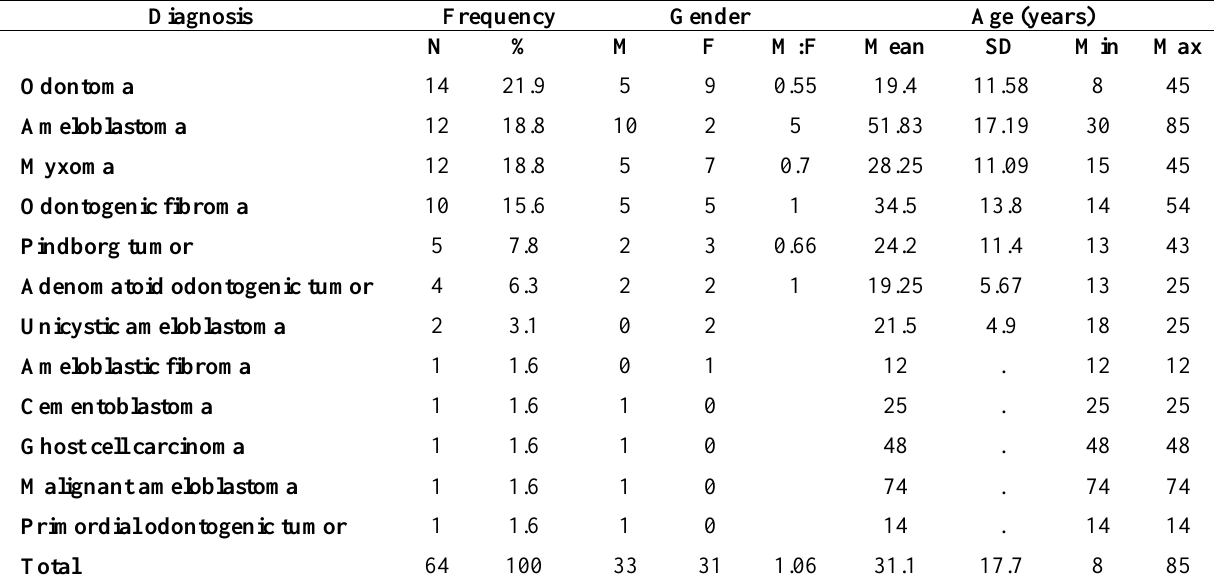
Table 2: The frequency and distribution of odontogenic tumors according to gender and age Diagnosis